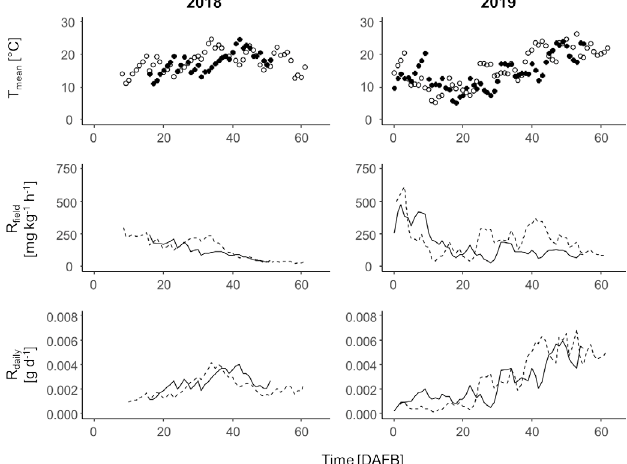
Fig. 5: Ti me course of average daily air temperature, measured at 2 m height, T mean , fruit respiration rate calculated for T mean , R field , and daily respired carbon per fruit, R daily , of developing 'Bellise' (closed symbol, solid line) and 'Regina' (open symbol, dashed line) sweet cherries during the growing seasons 2018 and